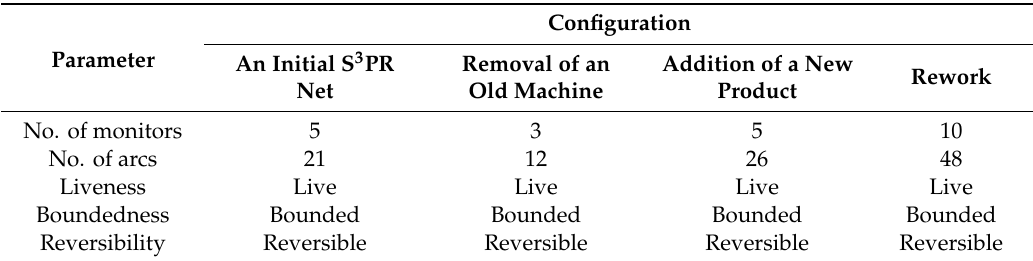
Table 2. The Specifications of S 3 PR net illustrated in Figure 16 under configurations.